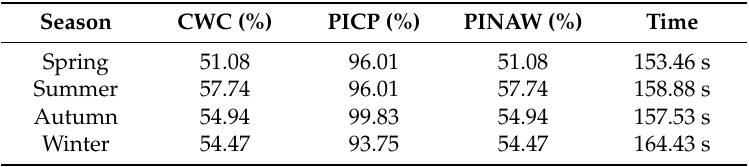
Table 4. Prediction results on four